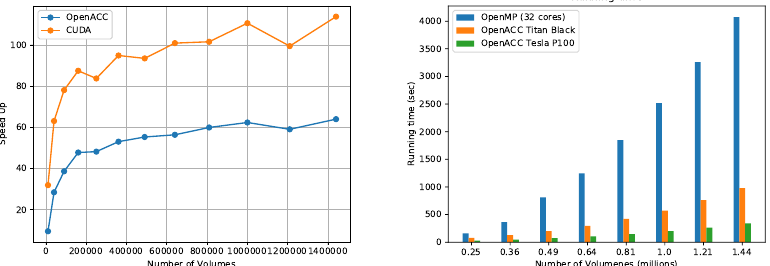
Figure A1. Speed up of OpenACC vs. CUDA (left). Running time of a OpenMP version vs. running time of an OpenACC version in two different graphical processor